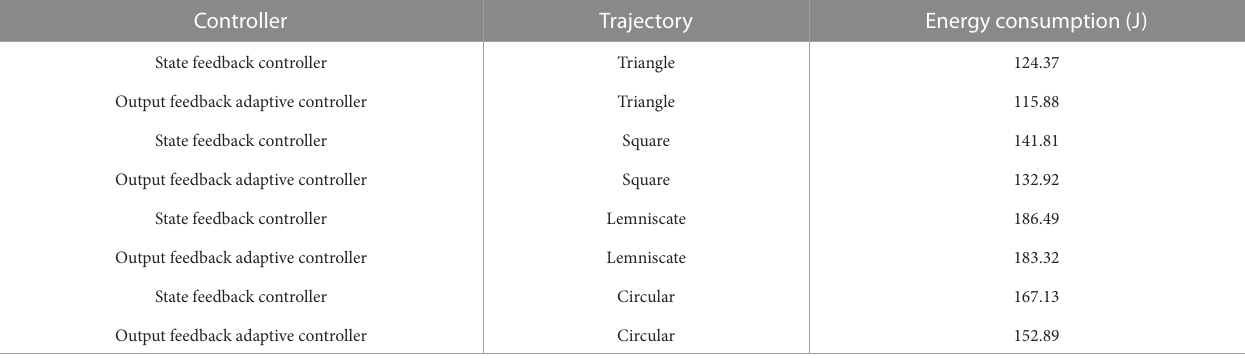
TABLE1 EnergyconsumedbytheSSARPwhenfollowingdifferenttrajectoriesinthex–yplane.